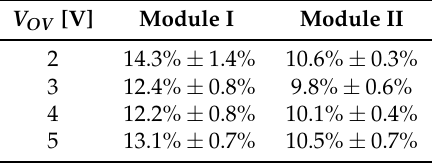
Table 2. The measured energy resolution ∆ E / E at 511 keV. The quoted value are mean resolutions of fired pixels in the module. The uncertainties are the standard deviations of the measured values in each